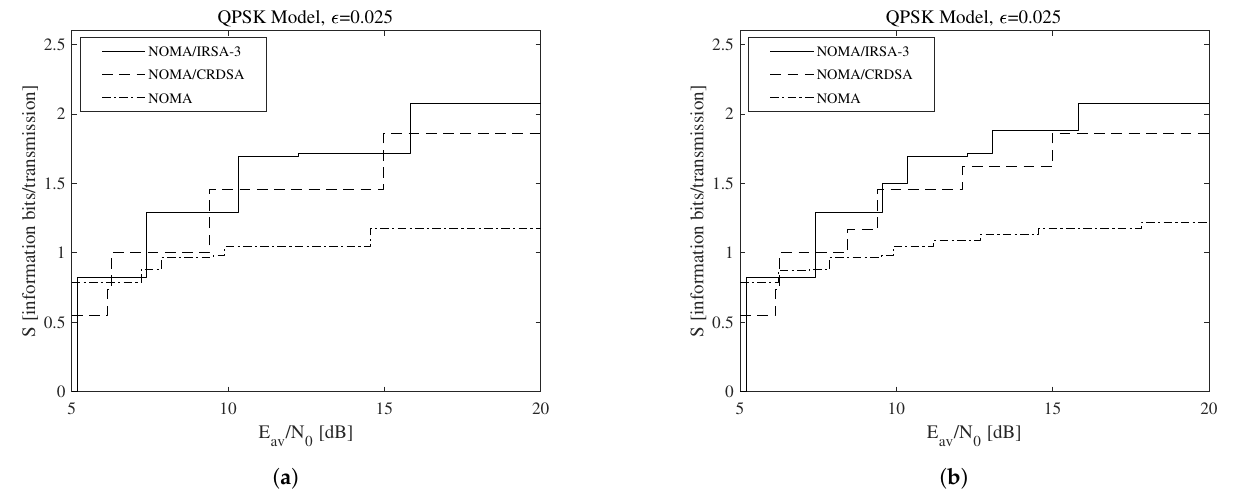
Figure 8. Throughput as a function of the available average SNR for (cid:101) = 0.025 and a discrete set of code rates adopting the QPSK modulation: ( a ) single code rate, ( b ) double code rate. Table 4. Discrete code rate/energy level designs for the NOMA/IRSA-3 scheme with (cid:101) = 0.025.